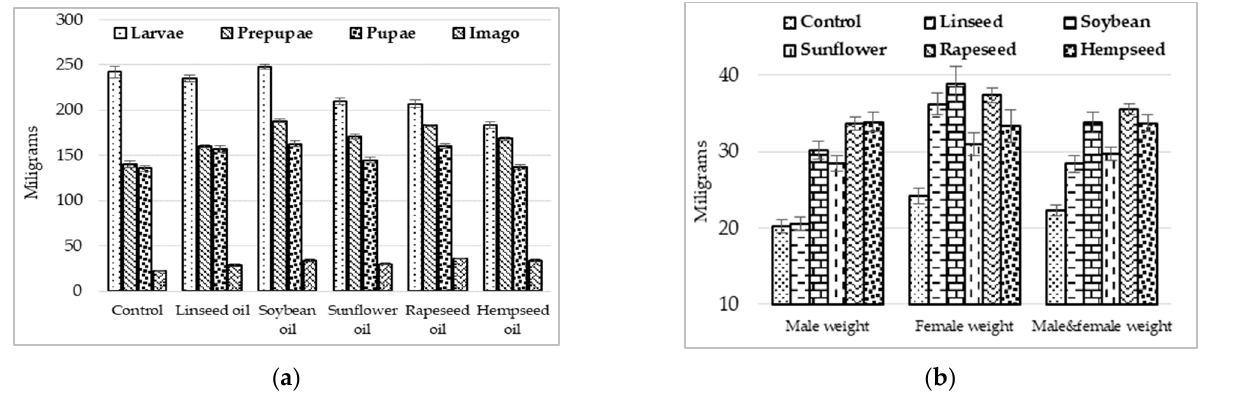
Figure 1. The effects of using different vegetable oils in the larval rearing substrate on the body weight evolution in different life stages of Hermetia illucens : larvae to imago stages ( a ); imago stages ( b ).